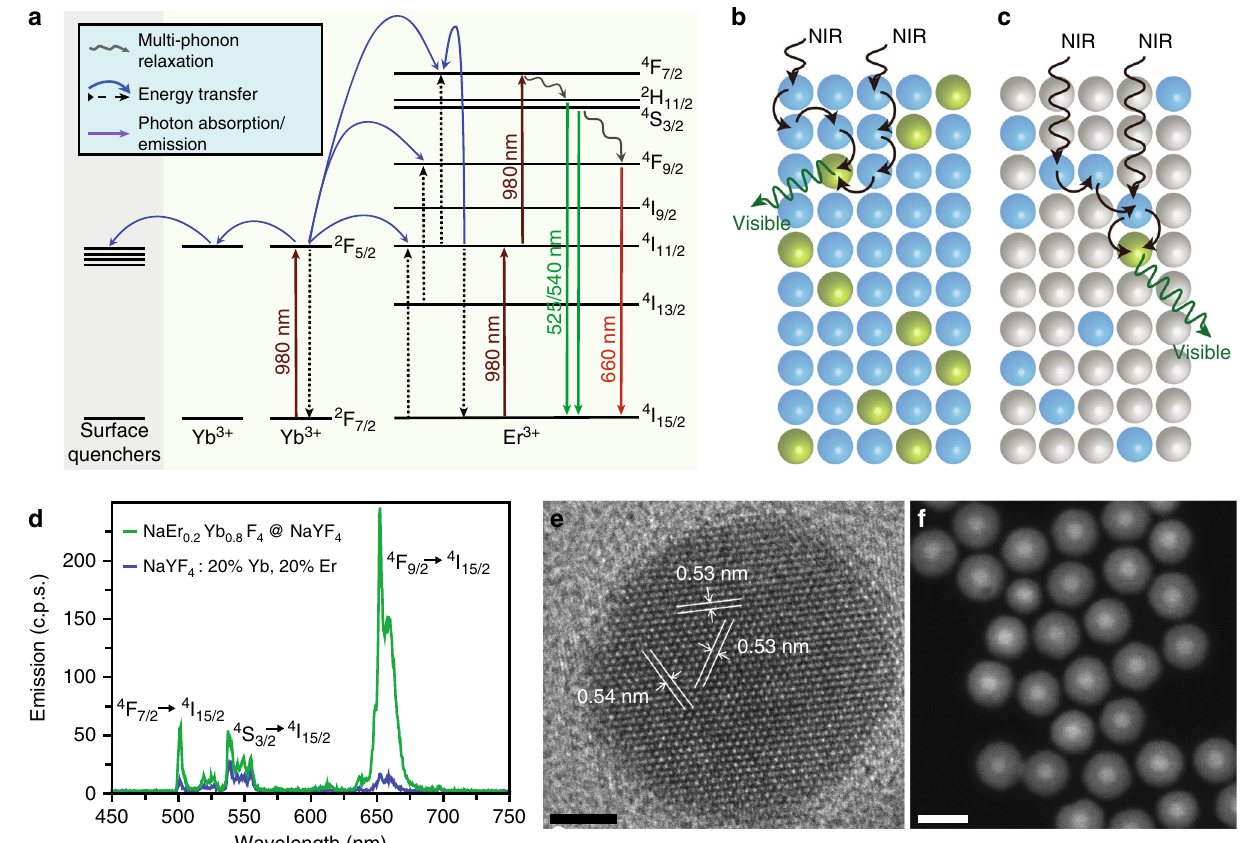
Fig. 1 Nanoparticles for low irradiance imaging. a Multiphoton energy absorption, transfer, surface loss, and emission in Yb 3 + /Er 3 + UCNPs and aUCNPs. Energy transfer pathways were calculated with a kinetic model as described 18,33 . Comparison of alloyed ( b ) and doped ( c ) UCNPs, showing energy transfer in matrix Y 3 + (gray), sensitizer Yb 3 + (blue), and emitter Er 3 + (green) ions. d Emission spectra of single core/shell NaYb 0.8 Er 0.2 F 4 aUCNPs and NaYF 4 : 20% Yb 3 + , 20% Er 3 + UCNPs under 2 × 10 6 W cm − 2 980 nm laser excitation. e High-resolution TEM image of an 8-nm NaYb 0.4 Er 0.6 F 4 with 4-nm NaY 0.8 Gd 0.2 F 4 shell (scale bar is 5 nm) and f high-angle annular dark- fi eld STEM of 8-nm NaYb 0.4 Er 0.6 F 4 with 8-nm NaY 0.8 Gd 0.2 F 4 shells (scale bar is 25 (Fig. 4f – j and Supplementary Fig. 7), and intensities <0.1 W cm − 2 can be used for imaging aUCNPs injected into live mice, as dis- cussed below. From these experiments, a revised UCNP design emerges in which there is no need to dope lanthanides into an inert matrix, as fully alloyed lanthanide UCNPs are brighter at all laser intensities.